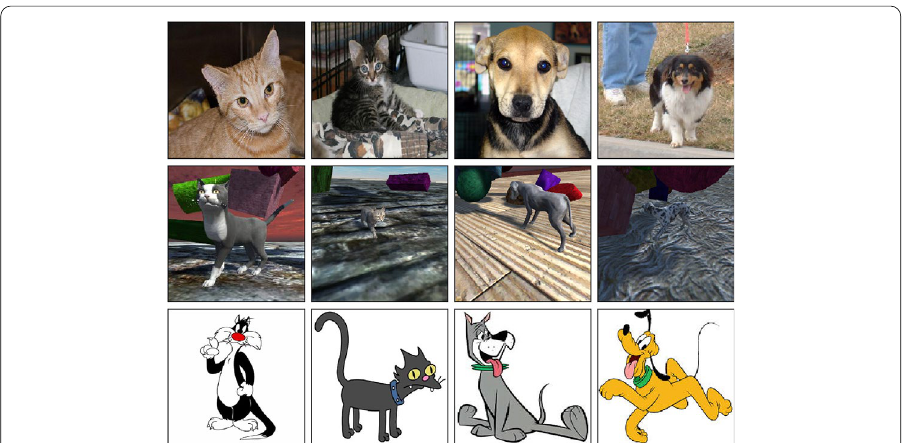
Fig. 6 Example of cat and dog images shown to our models across different domains. First row is of real world domain images. The second row shows a computer generated 3D domain similar to video games. Third row is a new animated based domain unseen to both models during training. Cartoon images are intellectual property of Warner Bros., Fox Broadcasting Company, Hanna-Barbara Productions and Walt Disney